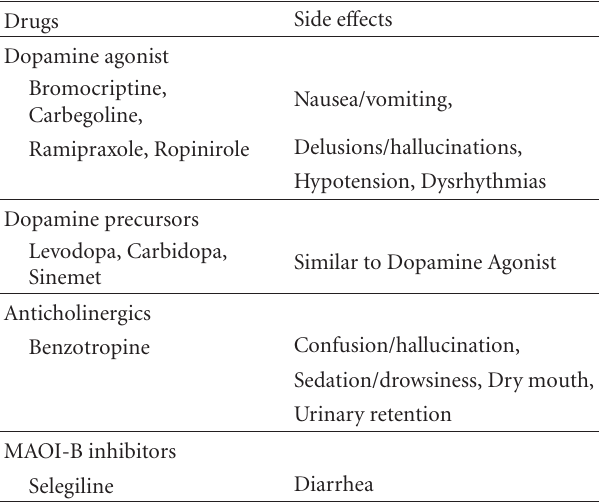
Table 5: Medical therapy for Parkinson’s